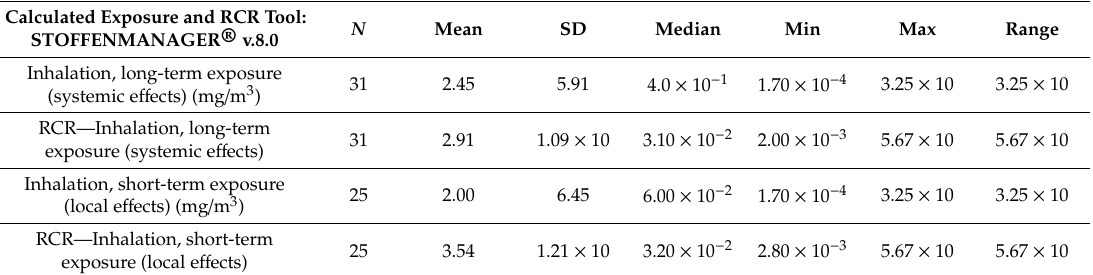
Table 7. Number of valid (N) exposure estimates calculated with STOFFENMANAGER ® v.8.0 model and associated RCRs for each route of exposure evaluated. SD: standard deviation; Min: minimum; Max: maximum.